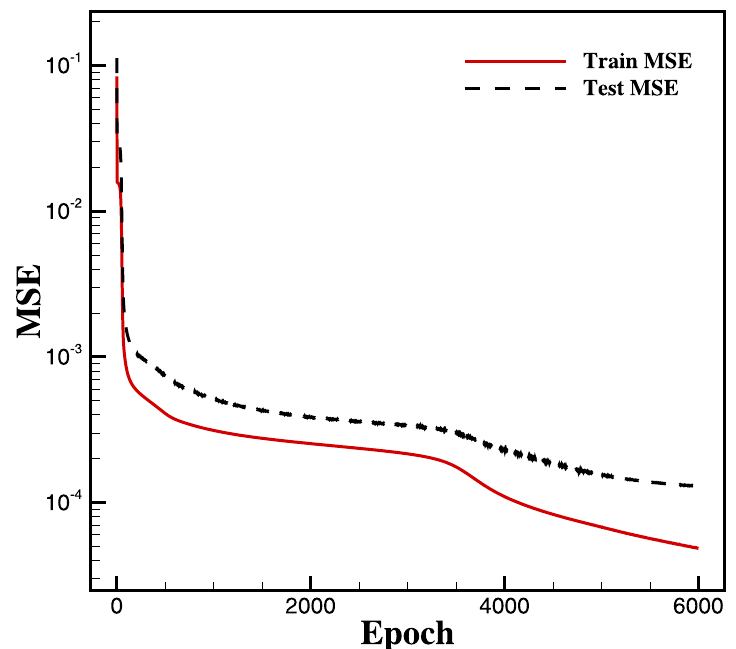
Fig. 19 Convergence history of MSE for the CNN